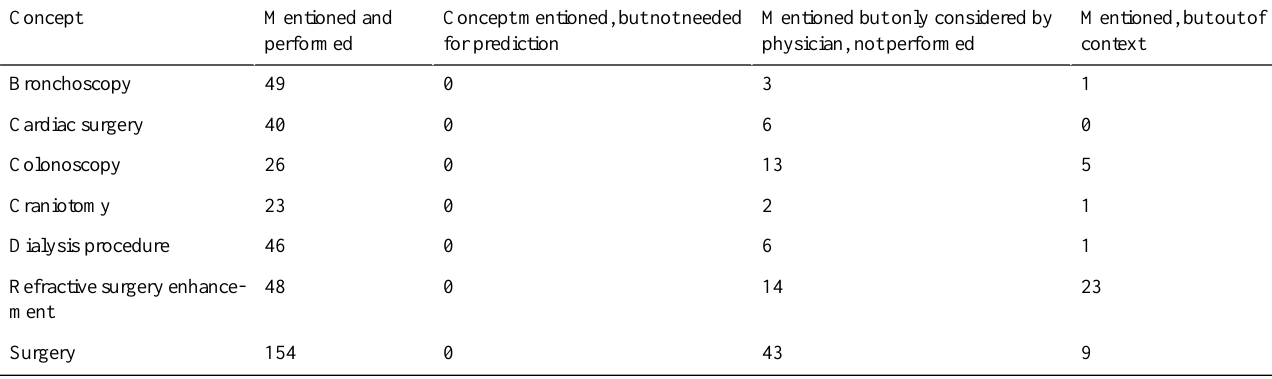
Table 6. Expert evaluation of false negative predictions using 4 fine-grained categories (for instance, surgery was not predicted to be in suffix, and it appears in the